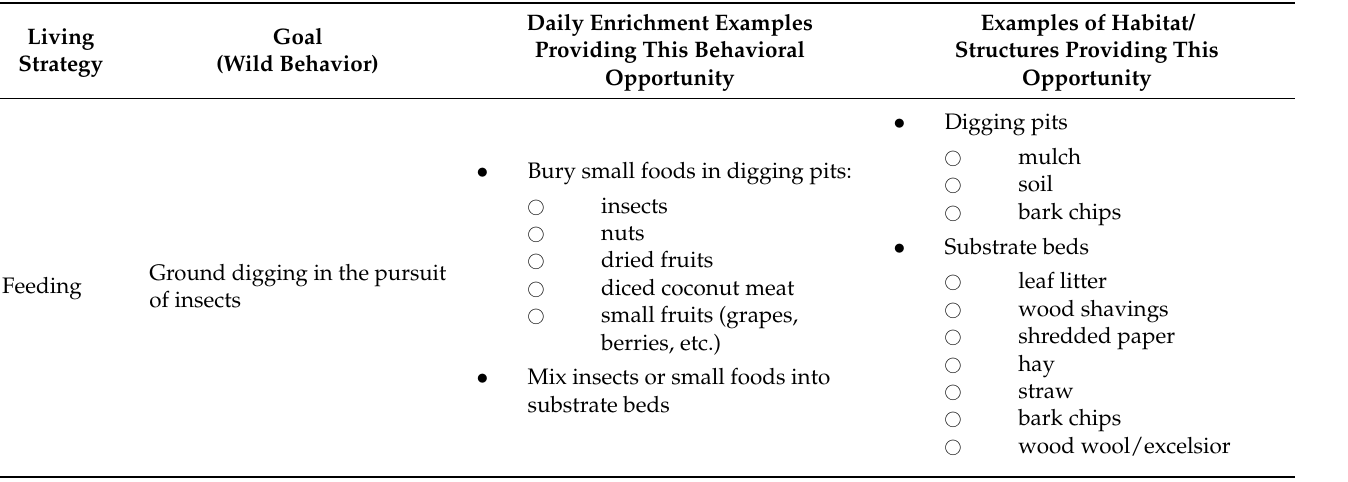
Table 1. Examples of behavior-based daily sloth bear